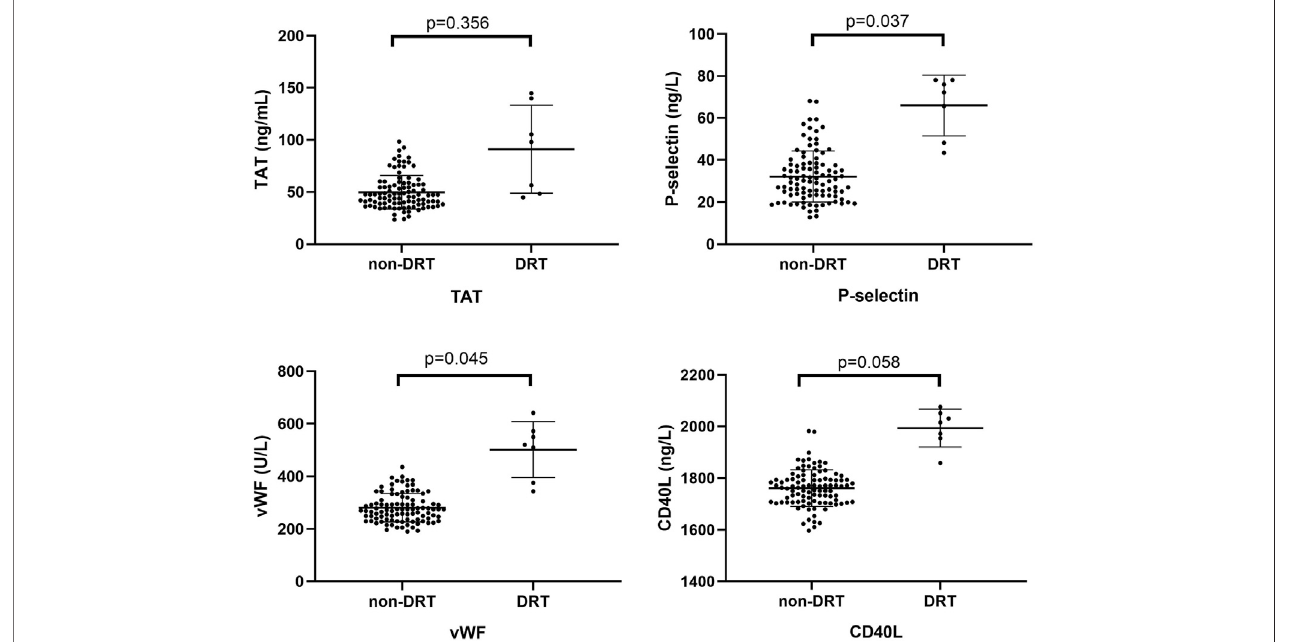
FIGURE4| Comparison ofplateletactivationbiomarkersbetweentheDRTand non-DRT groups.P-selectinand vWFplasmalevelsweresigni fi cantlyhigher inthe DRT compared with the non-DRT group ( p < 0.05). This was not seen in the TAT and CD40L groups ( p > 0.05).